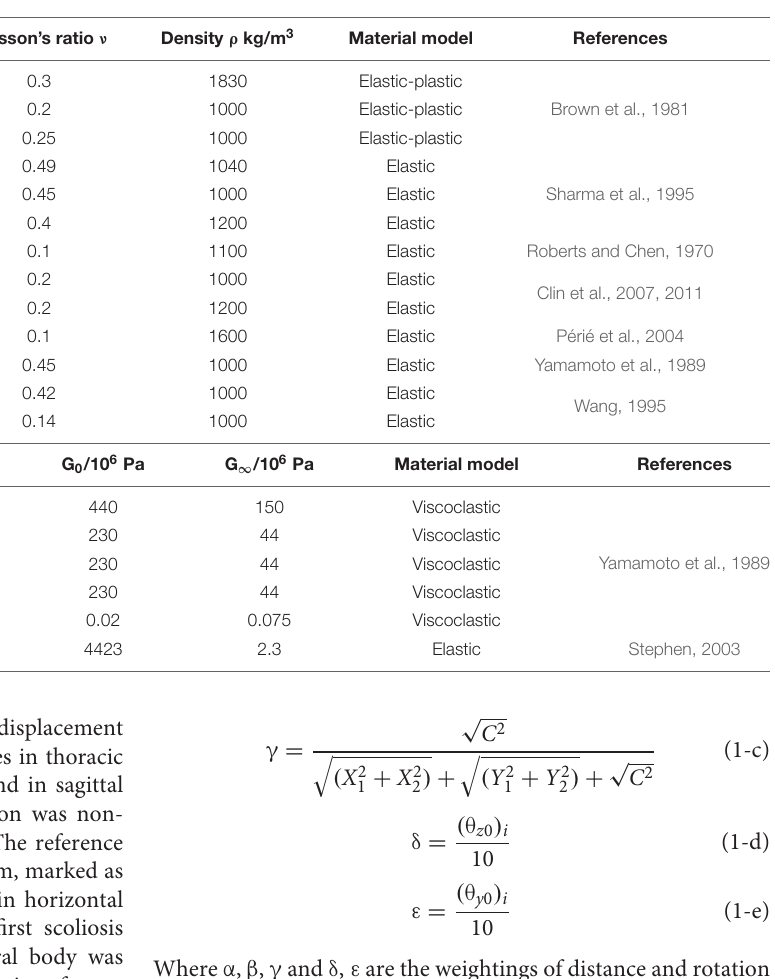
TABLE 1 | Material properties of each